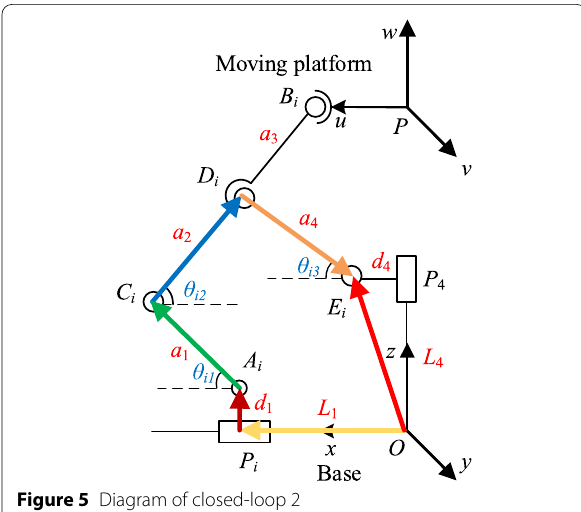
Figure 6 Diagram of closed-loop 3